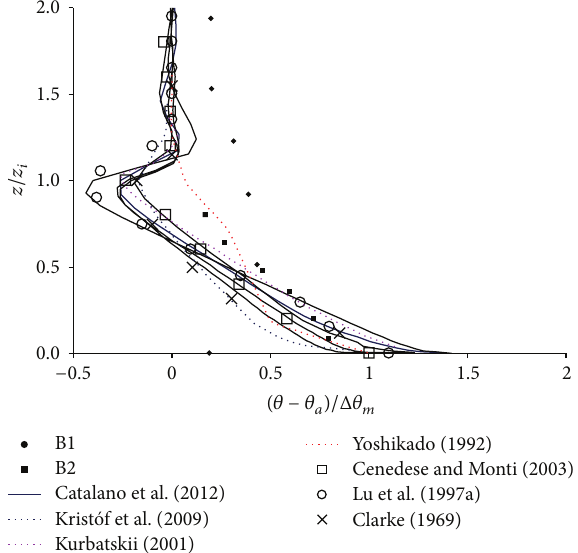
Figure 34: Vertical profiles of the nondimensional temperature anomaly at 𝑥/𝐷 = 0 for the numerical simulations and the laboratory experiments, compared with literature data: numerical results of Catalano et al. [92], Krist´of et al. [94], Kurbatskii [95], and Yoshikado [88]; laboratory experiments of Cenedese and Monti [97] and Lu et al. [24]; field observations of Clarke [78].